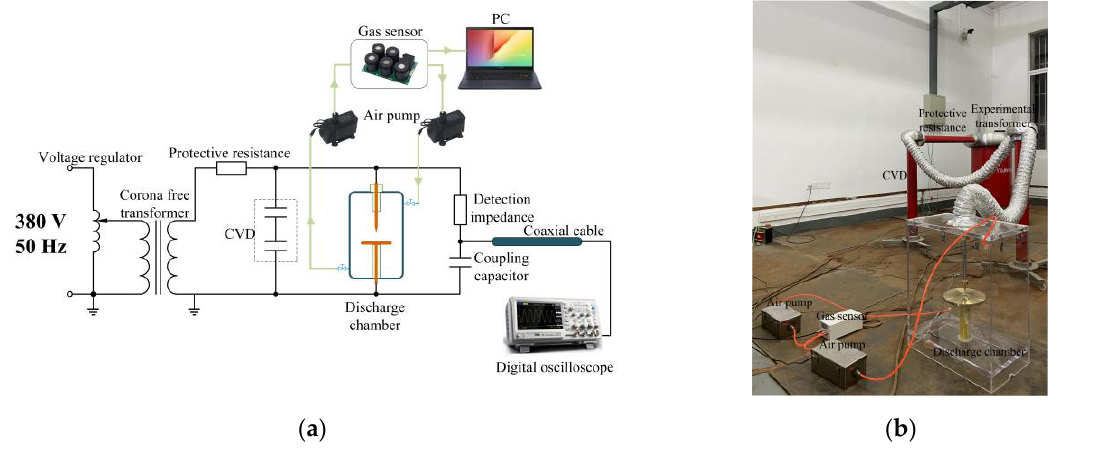
Figure 1. Experiment Platform : ( a ) schematic diagram of the experiment platform; ( b ) layout of the experiment platform.